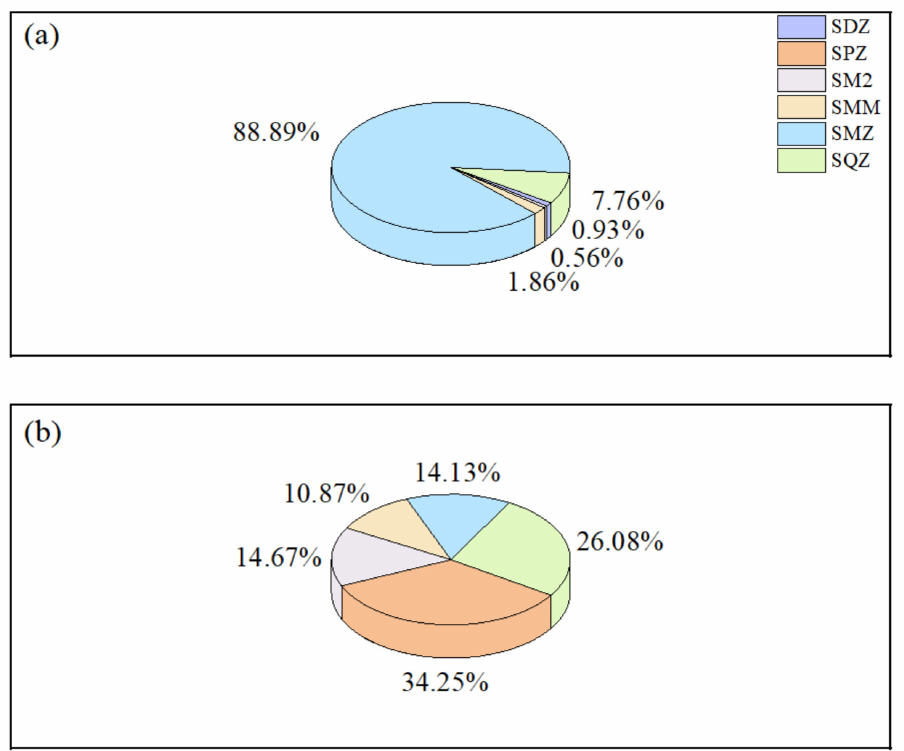
Figure 2. The proportion of sulfonamides: ( a ) the wet water period; ( b ) the flat water period. Currently, the consumption of antibiotics in various parts of China varies significantly, with greater quantities consumed in coastal areas than inland areas and southern regions than northern regions, which is also correlated with the regional economic